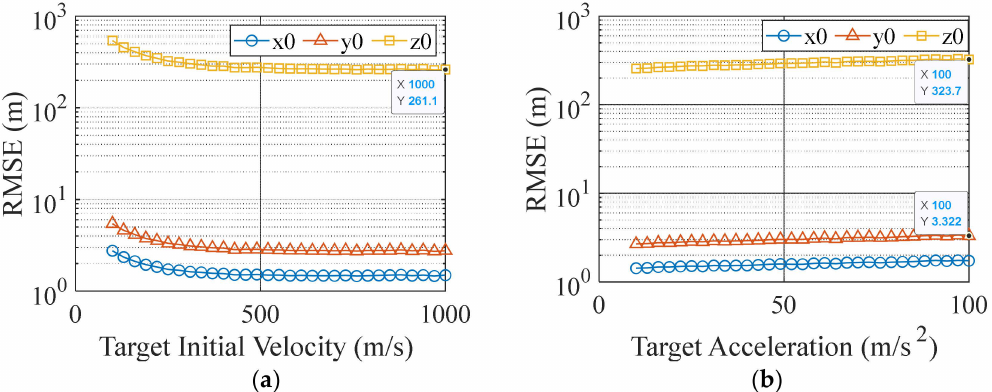
Figure 6. Influence of target motion on parameter estimation accuracy. ( a ) Influence of initial velocity ( a = 50 m/s 2 ). ( b ) Influence of acceleration (v = 350